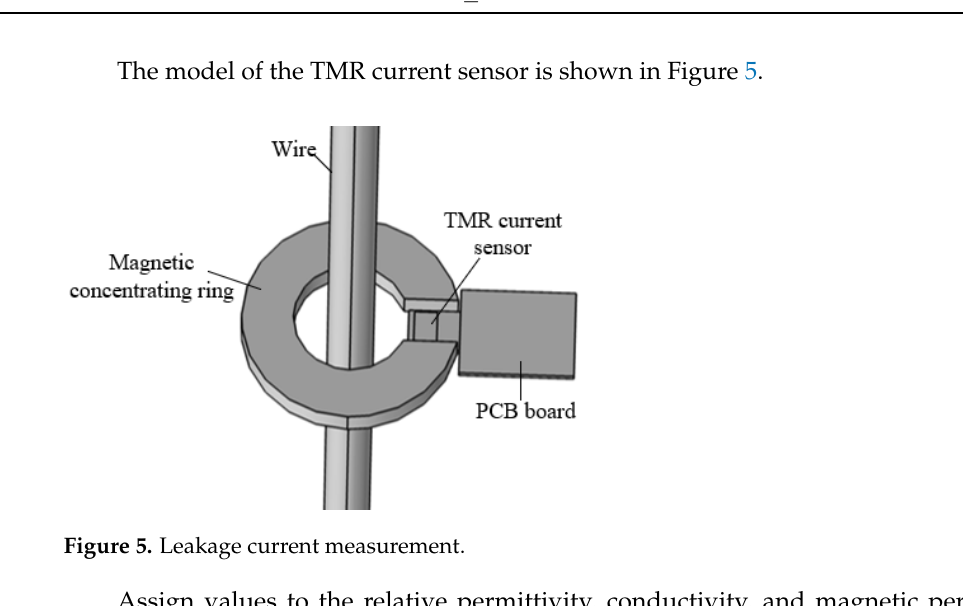
Figure 4. The structure of the 500 kV ZnO arrester. ( a ) an overall diagram of the 3D model; ( b ) the structural composition of the arrester.